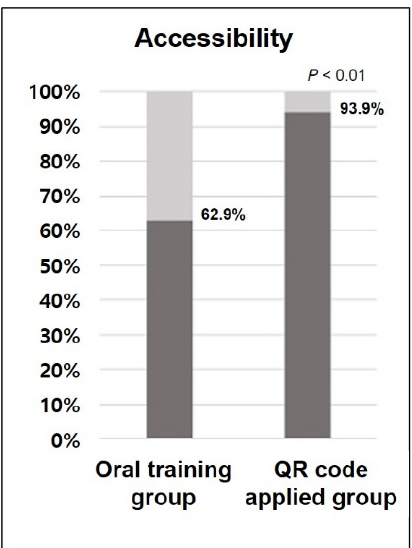
Figure 3. The difference in frequency of retraining (accessibility) between the oral training group and QR code applied group.